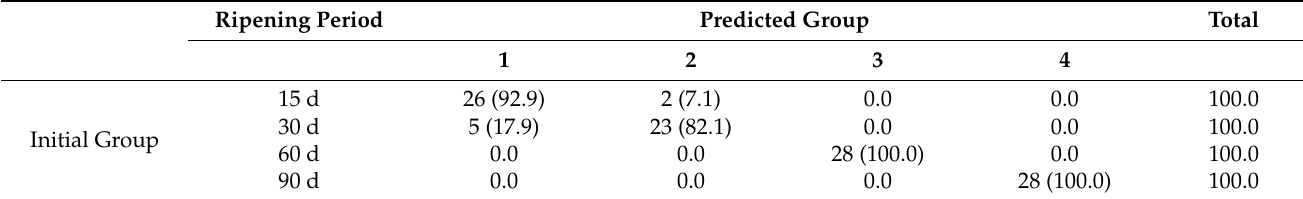
Table 8. Stepwise discriminant analysis of cheese samples according to ripening period, numbers and (%). Ripening